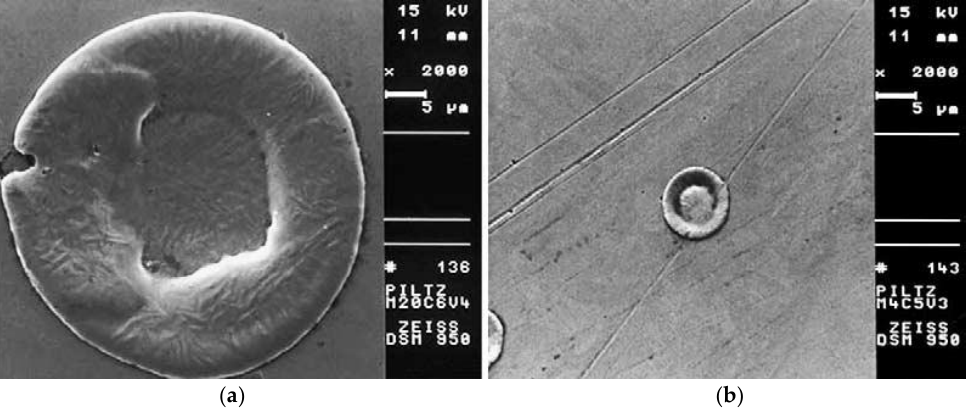
Figure 8. Comparison between crater dimensions in ( a ) conventional EDM (left) and ( b ) micro-EDM (right) (Reproduced with permission from [51]).